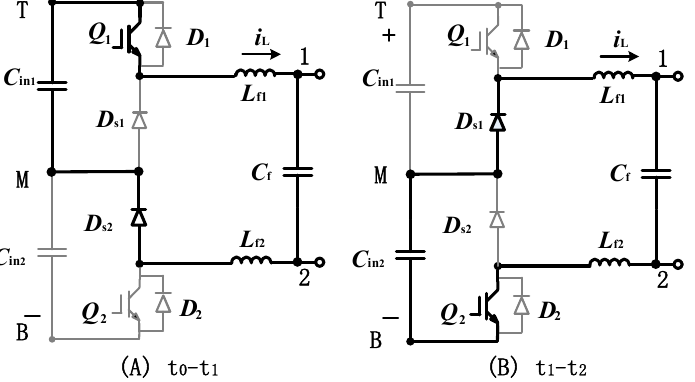
Figure 6. Operating stages and equivalent circuits for D = 0.5.